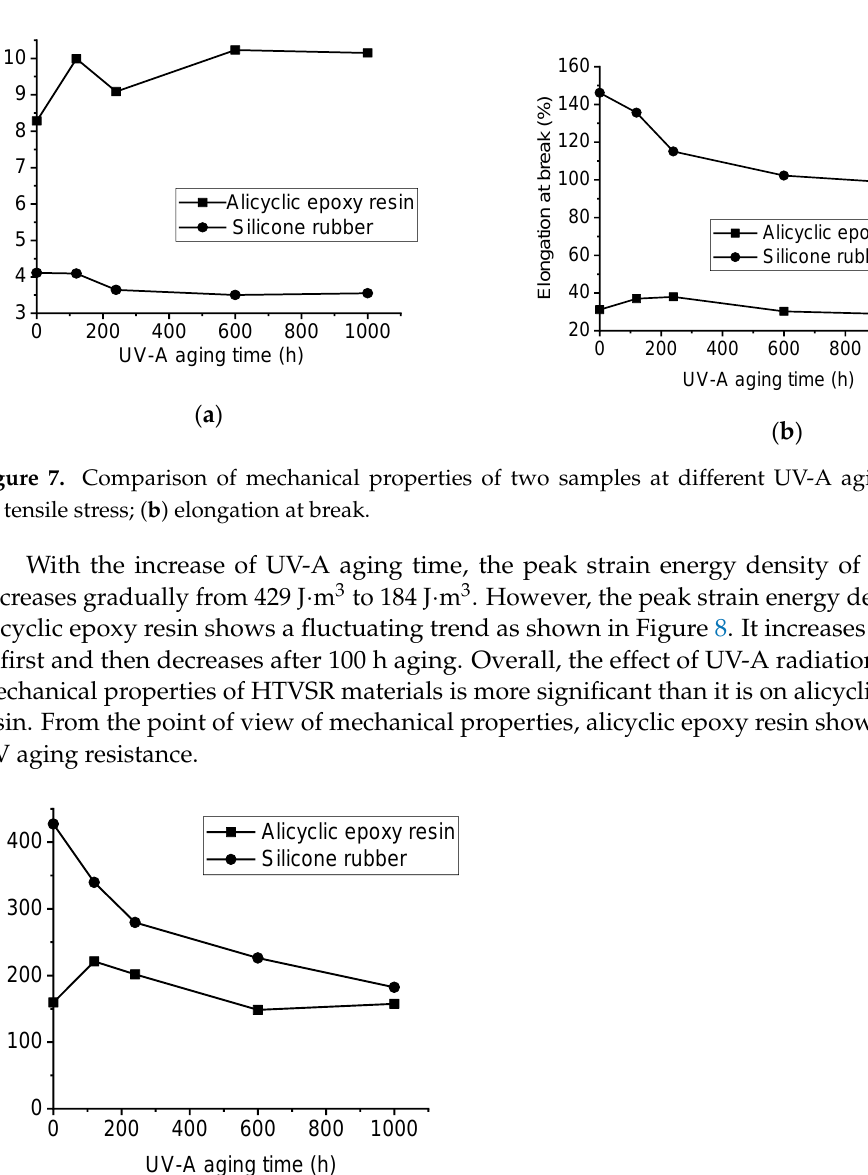
Figure 8. Comparison of the peak strain energy density of two samples at different UV-A aging time.